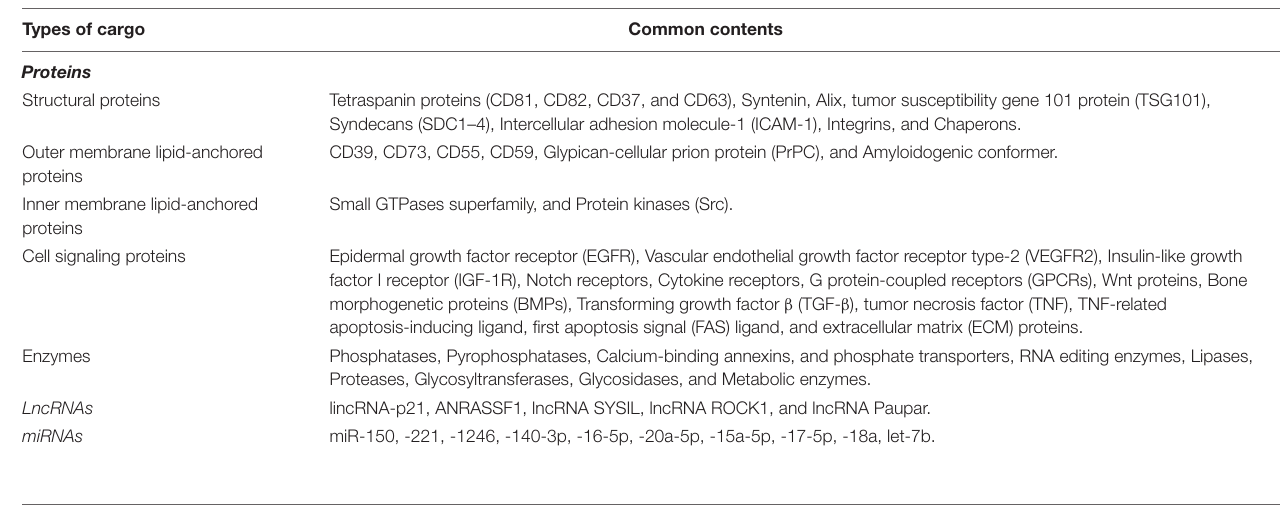
TABLE 1 | The content of circulating